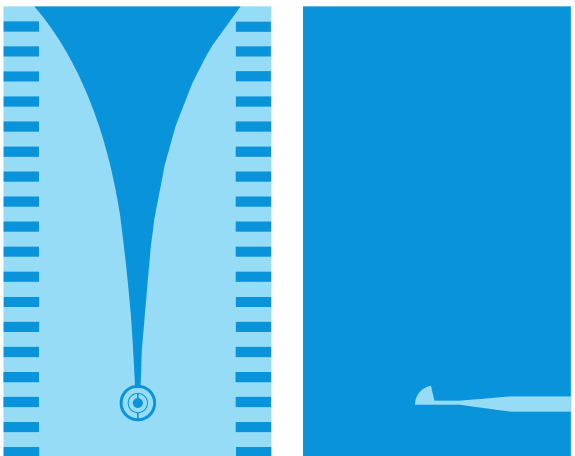
Figure 3. Geometrical structure of the